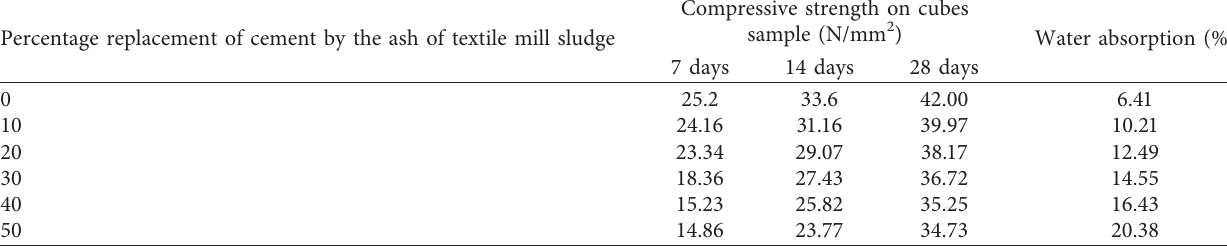
Table 4: Compressive strength of concrete cubes using different cement replacements.